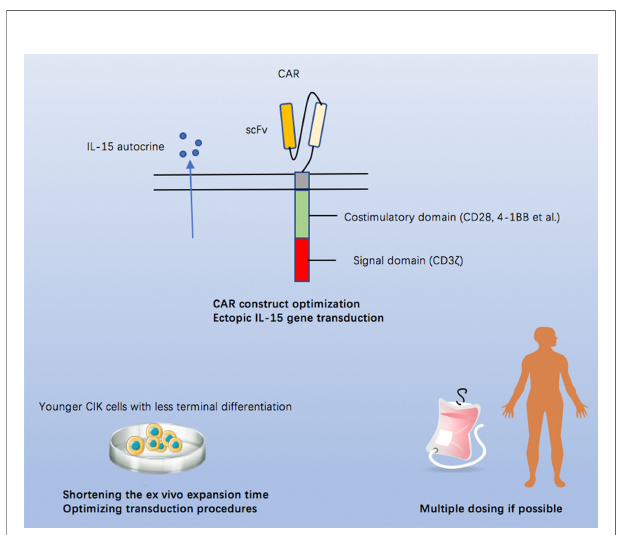
FIGURE 1 | Possible approaches to improve the potency or ef fi cacy of CAR CIK